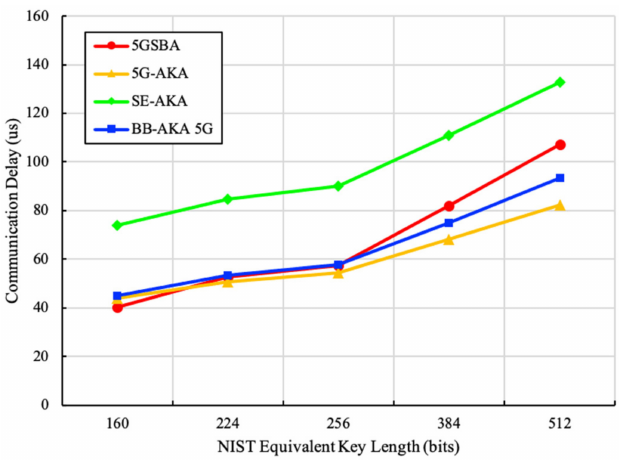
Figure 8. Total communication